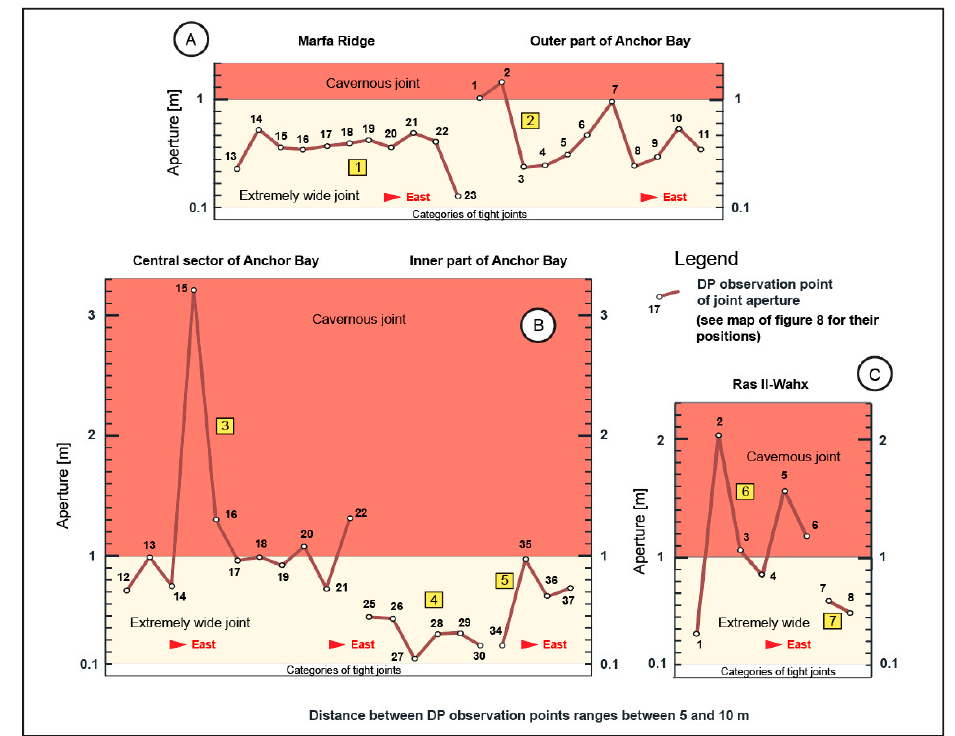
Figure 10. DP analysis of aperture variations of: ( A ) Joint # 1 and Joint#2; ( B ) Joints located in the central and inner part of Anchor Bay; and ( C ) Joints located along the edge of Ras Il-Wahx plateau.